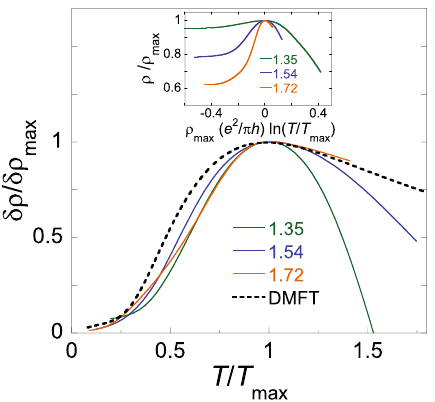
Figure 3. The ratio δρ/δρ max plotted as a function of T / T max in B = B ∗ . The electron densities are indicated in units of 10 10 cm − 2 . The dashed line is the result of DMFT in the weak-disorder limit 26,28,29 . The inset shows the analysis based on the scaling form suggested by the renormalization-group scaling theory 34,35